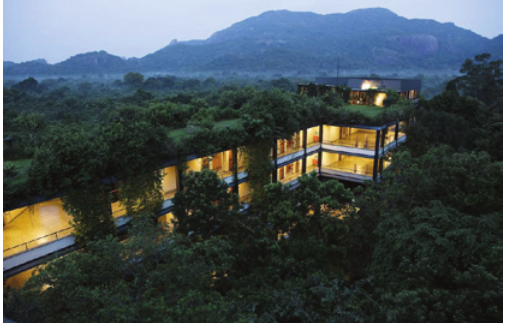
Figure 7. University of Ruhuna, Matara, Sri Lanka Figure 8. Heritance Kandalama, Dambulla, Sri